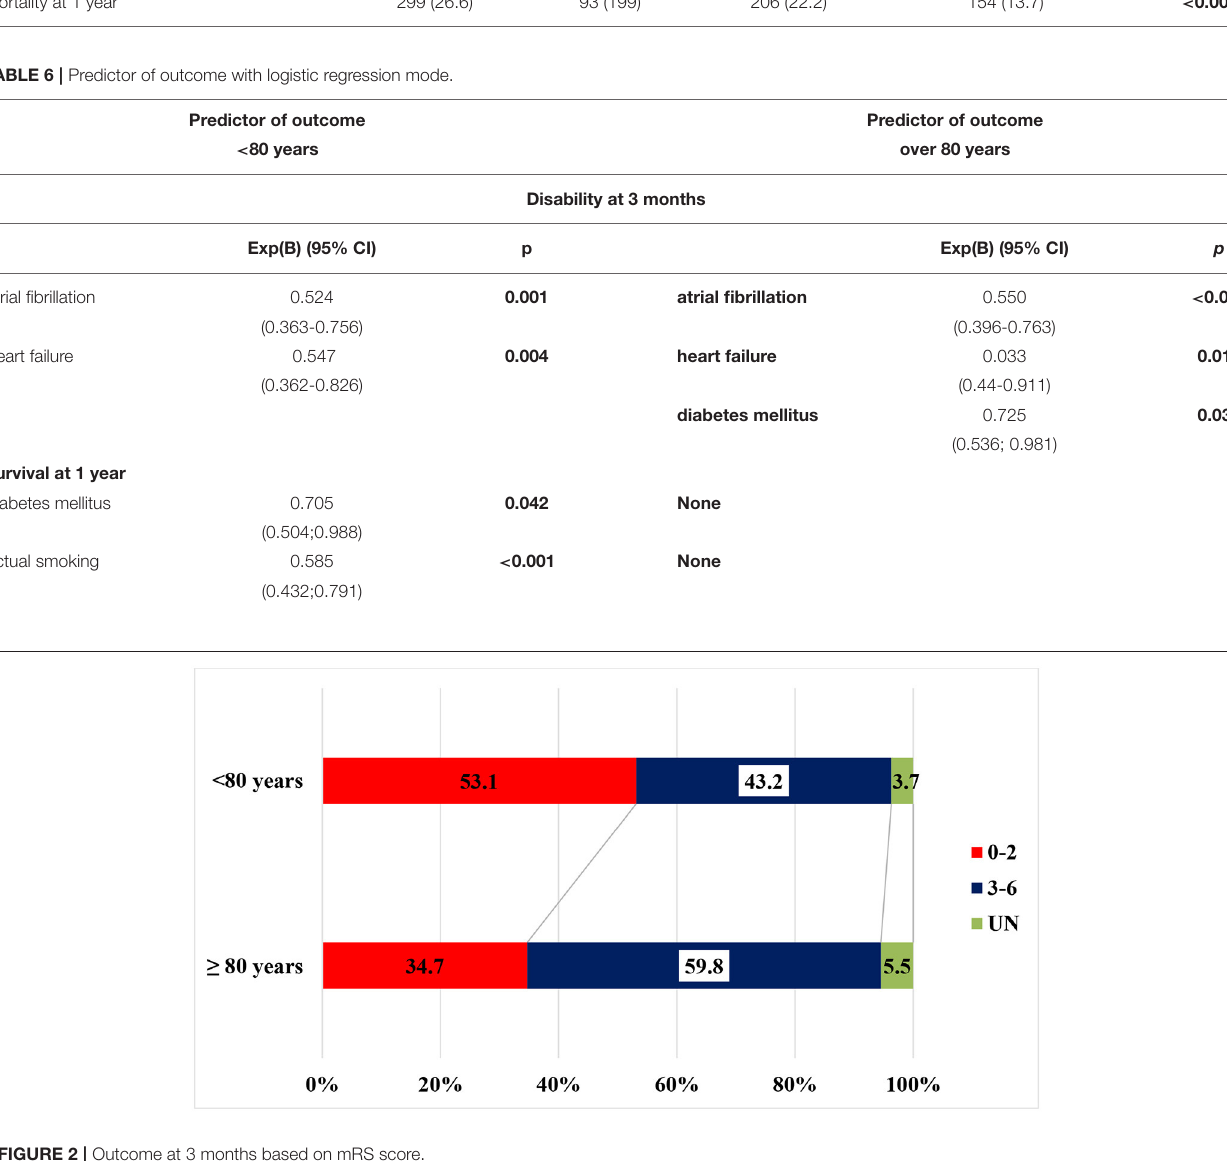
FIGURE 2 | Outcome at 3 months based on mRS